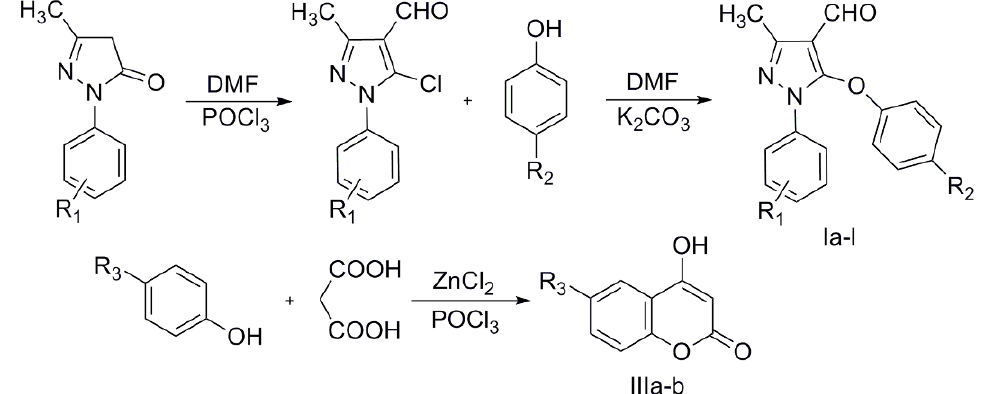
Scheme 1. Synthetic pathway for the compounds Ia-l and IIIa-b